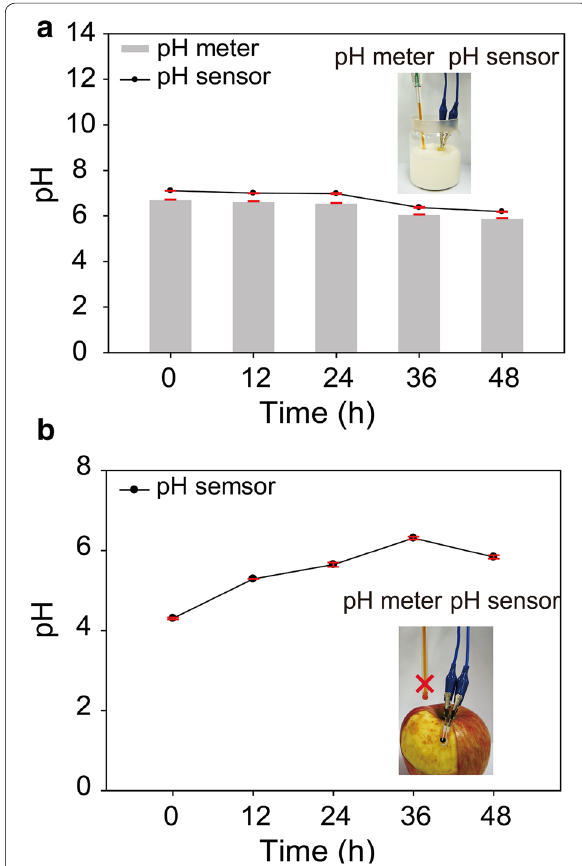
Fig. 7 a Milk and b apple spoilage measurements using pH sensor and pH meter (OrionTM Star